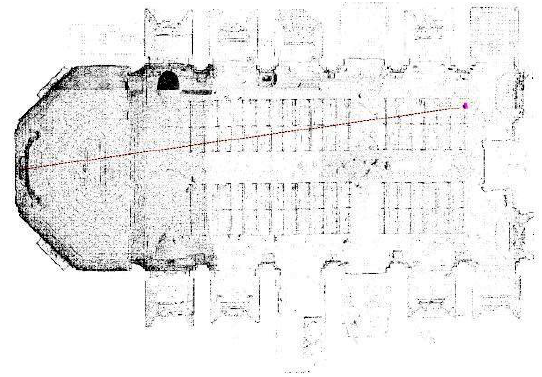
Figure 7. Shooting position of the oblique frame.